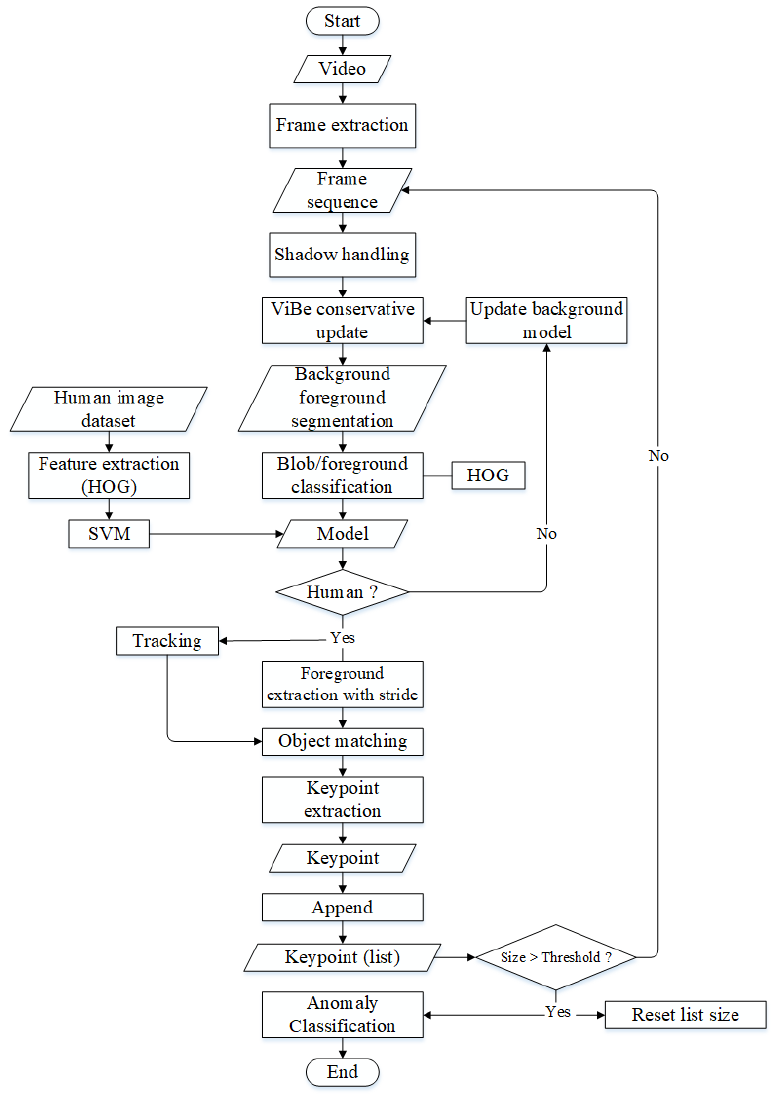
Figure 1. The proposed method